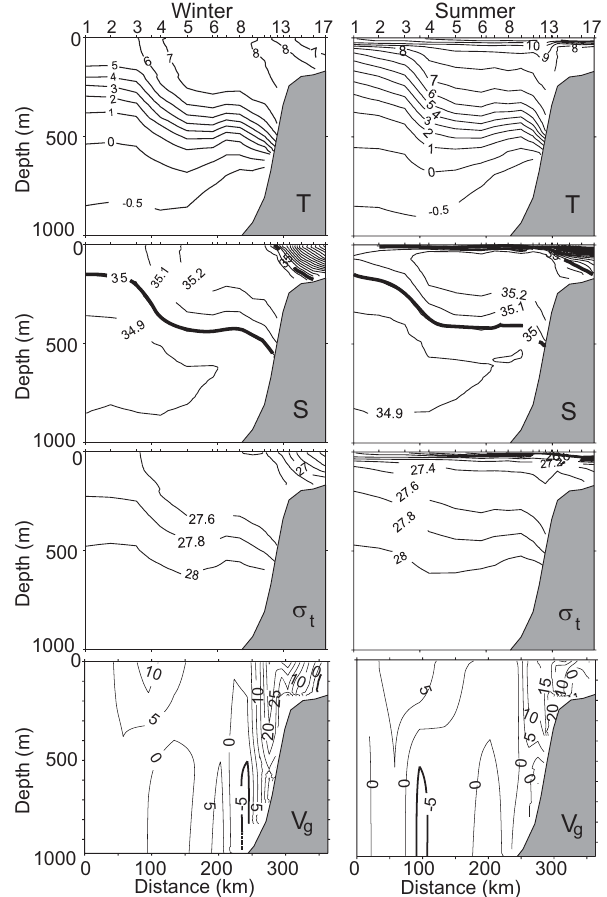
Fig. 4. Cross-sections of temperature, salinity, density ( σ t ) and ab- solute velocity (cms − 1 ) averaged for winter and summer.